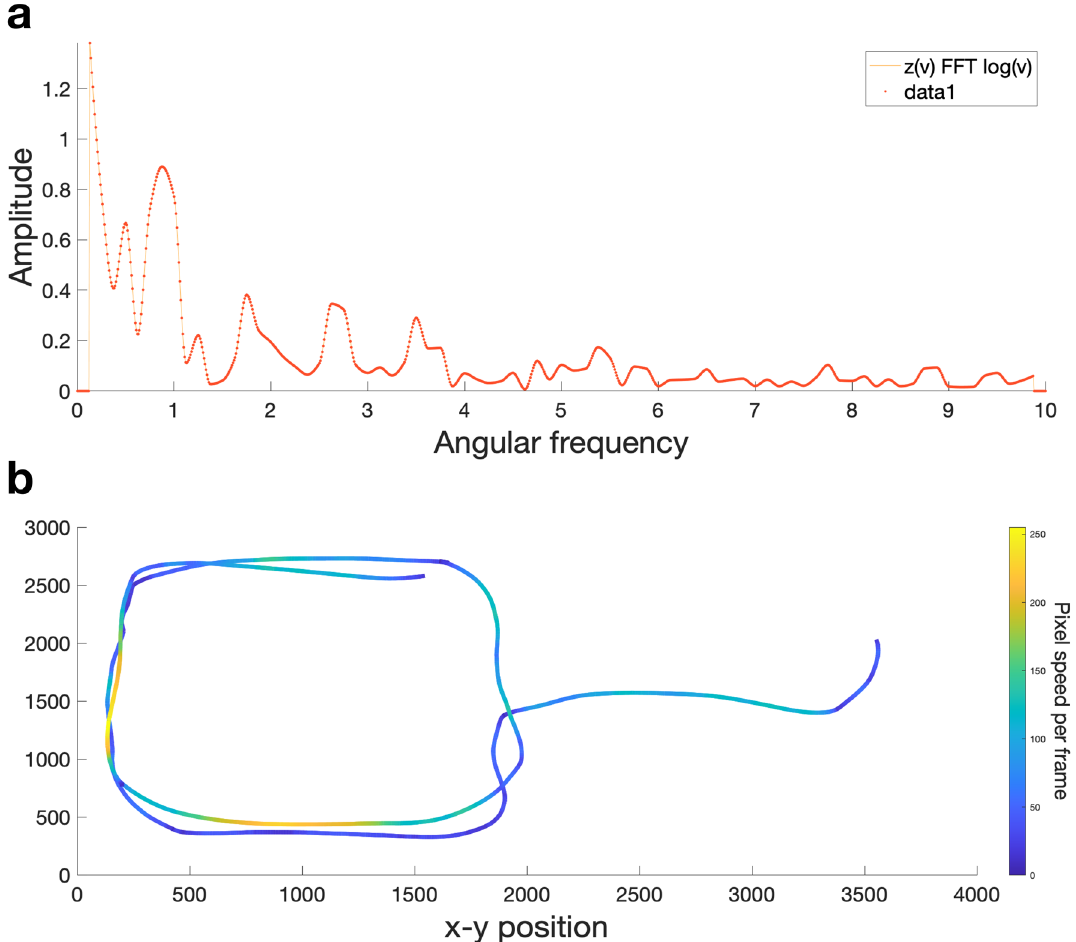
Figure 6. Example of trajectory shape and related angular frequency spectrum. ( a ) Example of angular frequency spectrum for following animation. ( b ) Related trajectory (of one of two triangles). Trajectory colors indicate speed